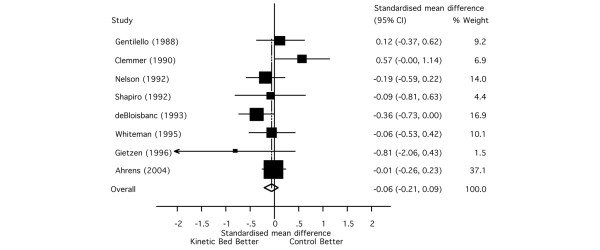
Forest plot showing the effect of kinetic bed therapy on intensive care unit length of stay. CI, confidence interval.